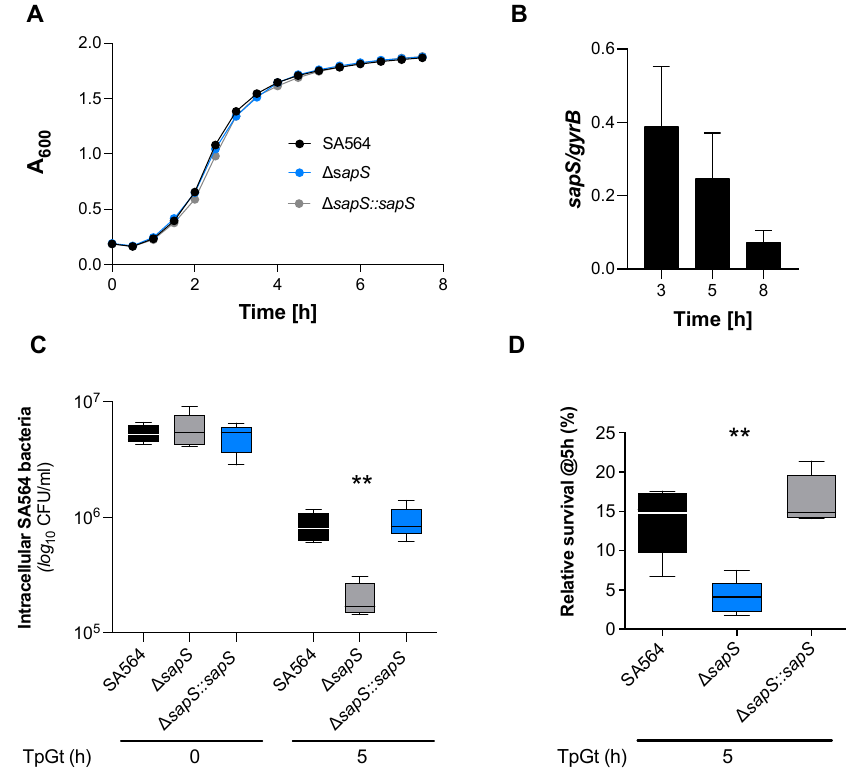
Figure 1. SapS has no impact on S. aureus SA564 growth in vitro but contributes to intramacrophage survival. ( A ) Growth kinetics of S. aureus strains SA564 (black symbols), SA564 Δ sapS (blue symbols), and SA564 Δ sapS::sapS (grey symbols) in TSB. Cells were cultured at 37 °C and 150 rpm in 96-well plates using a Spark 20M (Tecan, Trading AG, Männedorf, Switzerland) microplate reader. Data represent the mean A 600 readings ± SD at the time points indicated (n = 3; error bars are too small to be visible). ( B ) Transcription of sapS during growth in TSB. Cells of SA564 were cultured at 37 °C and 225 rpm in a culture to flask volume of 1:10, and after 3 h, 5 h, and 8 h of growth, cells were harvested, total RNAs isolated, and qRT-PCRs performed for sapS . Transcripts were quantified in reference to gyrase B mRNA. Data are presented as mean + SD of five biological replicates. ( C , D ) Survival of S. aureus strain derivatives in infected RAW 264.7 macrophages. CFU rates recovered from infected cells lysates at the time points indicated. Data are presented as mean + SD (n = 5 biological replicates) ( C ) and survival rates expressed in relationship to the intracellular bacterial cell counts that were detected immediately after the gentamicin/lysostaphin treatment (T0), which was set to 100%. The data are displayed as box and whisker plots, displaying the median (horizontal line), interquartile range (25–75% box), and standard deviation (bars) of five different experiments ( D ). **, p < 0.01 (Kruskal–Wallis test followed by Dunn’s post-hoc test). TpGt, time post gentamicin